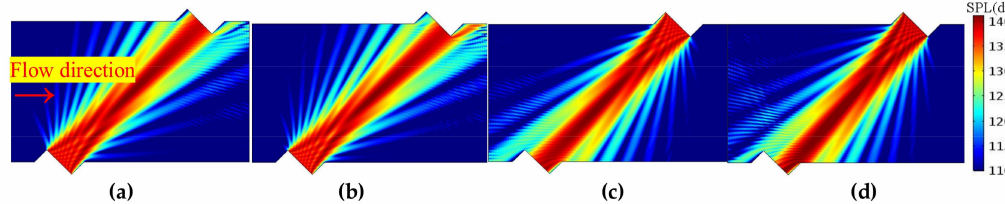
Figure 12. Acoustic beam for the U (i.e., uniform) profile (flow direction is from left to right). ( a ) Downstream, v = 12.82 m/s. ( b ) Downstream, v = 31.86 m/s. ( c ) Upstream, v = 12.82 m/s. ( d ) Upstream, v = 31.86